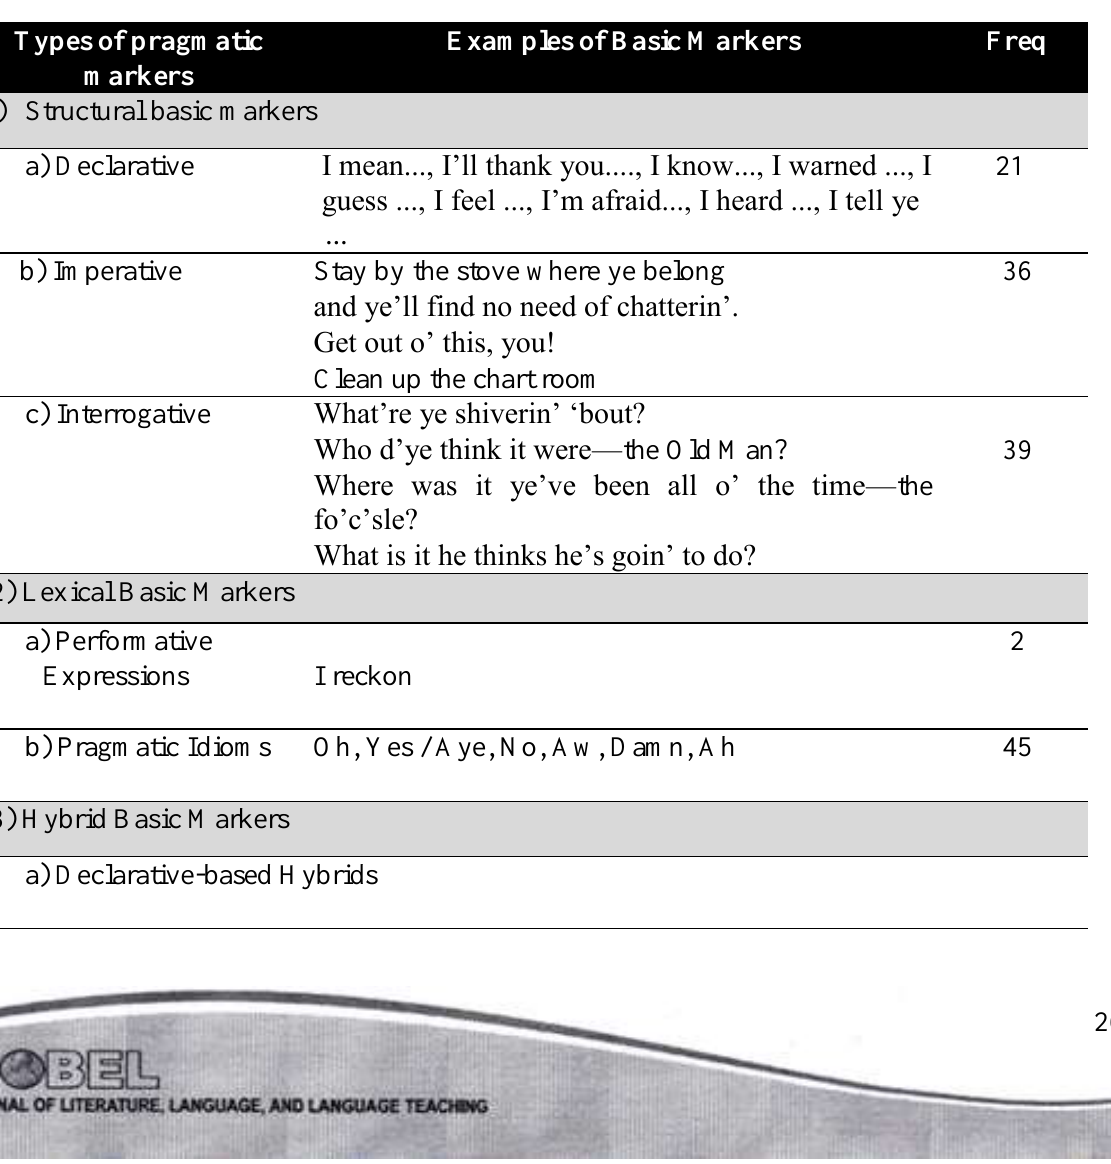
Table 1: Basic Markers in